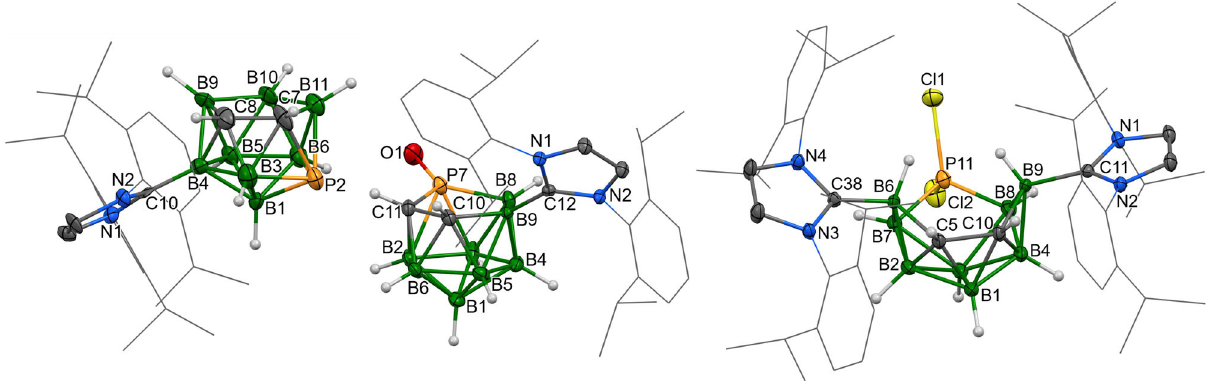
Fig. 5 The molecular structures of o -1a (left), o -1b (centre) and o -2b (right). ORTEP-type plots, 40% probability level. Chloride anion and dichlormethane solvates are omitted for clarity in o -2b . The 2,6-diisopropylphenyl groups are displayed as wireframes for